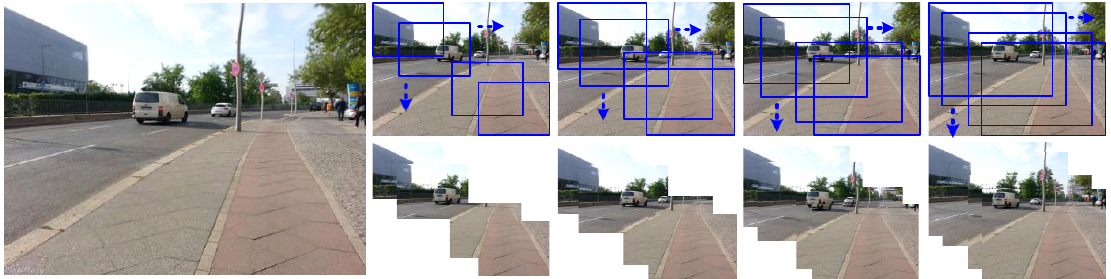
Figure 3. An example of extracting 100 landmarks from four scales by MSW. The left image shows the original image. The top right four images illustrate the uniform sampling process with 0.16, 0.25, 0.36 and 0.49 scales, respectively. Twenty-five landmarks are extracted from each scale in this case. The bottom right four images show the examples of landmarks extracted by MSW with four different